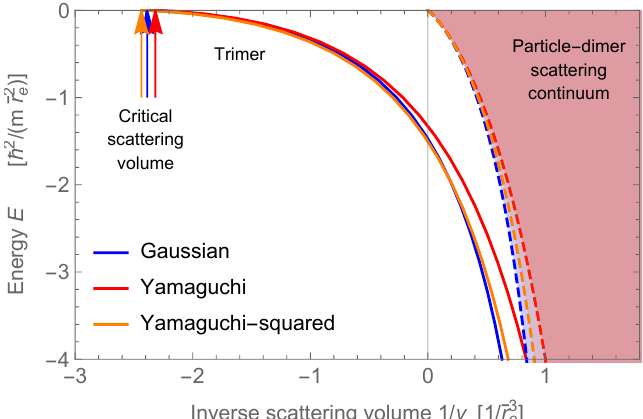
Figure 10: Three-body spectrum as a function of the inverse scattering volume 1 / v between the two fermions, for a fermion-particle interaction at the s-wave unitarity ( a = ∞ ) and mass ratio x = 9. The solid curves indicate the trimer energy for different models and the dashed curves indicate the p-wave fermion-fermion dimer energy. The arrows indicate the critical scattering volume v at which the trimer c appears from the three-body scattering threshold. This critical scattering volume corresponds to the value beyond which the trimer is borromean with respect to the fermion-particle dimer, as seen in Fig. 8.